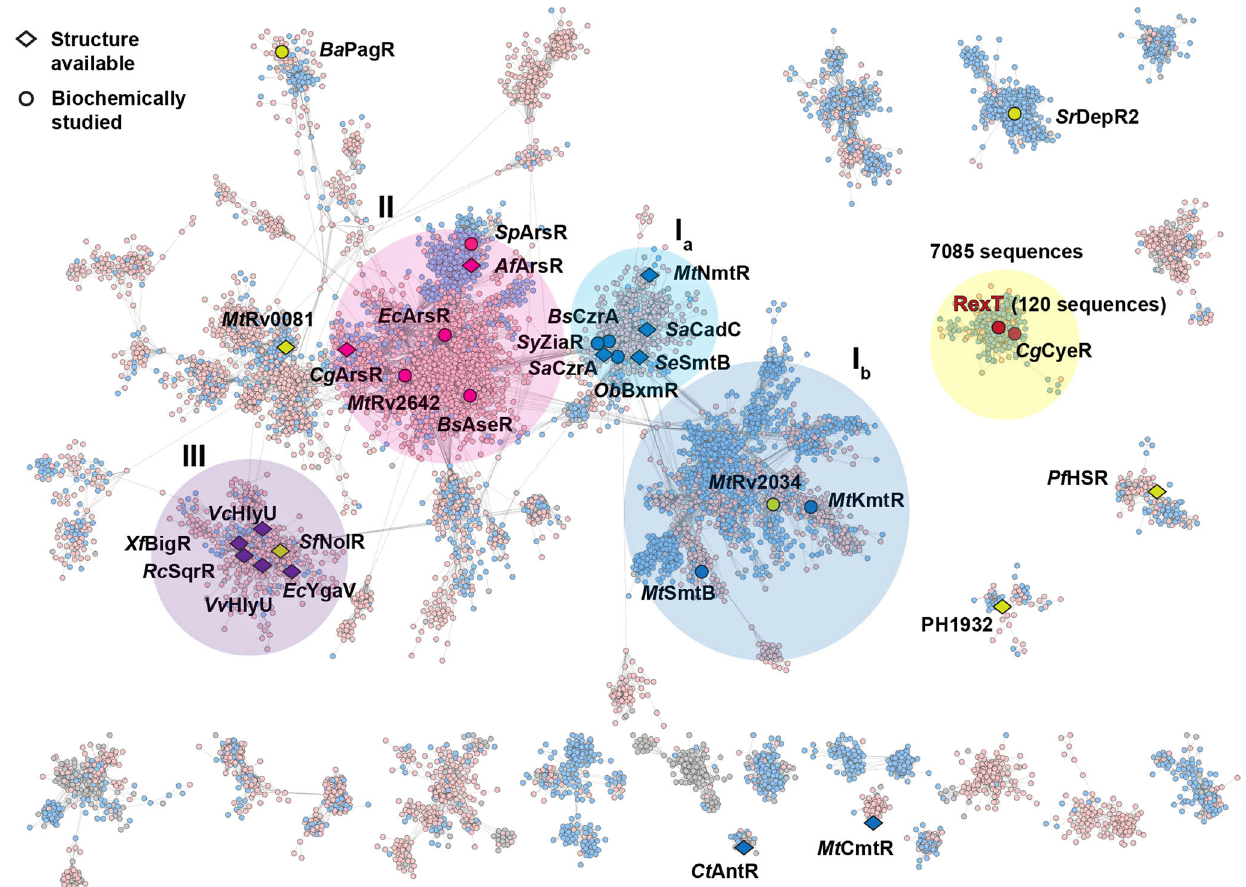
Fig. 6 A sequence similarity network (SSN) of the ArsR-SmtB regulator family reveals RexT forms a distinct class of its own. The SSN 39 was constructed using the EFI server 81,85,86 with 20616 UniRef50 sequences that contain an annotated “ HTH ArsR-type DNA-binding domain ” (IPR001845) and analyzed by Cytoscape 83 with a cut-off value of e − 20 . The nodes are colored by their Pfam classi fi cation: pink nodes represent the 10600 sequences from PF01022 (HTH_5) and blue nodes represent the 7564 sequences from PF12084 (HTH_20). Only the main body of the network that contains proteins of interest are shown. Regulators that have been previously biochemically or structurally characterized are highlighted in circle and diamond shapes, respectively. These shapes are color-coded to denote the signal that these regulators sense (blue: metal-binding; pink: arsenite-binding; purple: putatively redox-based; yellow: unknown mechanisms) The main cluster of nodes is colored by large circles to differentiate regulators that use the α 5 helix to bind metal ions (circles I a and I b ), Cys residues to bind an arsenite or a methyl-arsenite anion (circle II), or do not bind a metal ion at all (circle III). Organism abbreviations: Af Acidithiobacillus ferrooxidans , Ba Bacillus anthracis , Bs Bacillus subtilis , Cg Corynebacterium glutamicum , Ct Comamonas testosterone ,